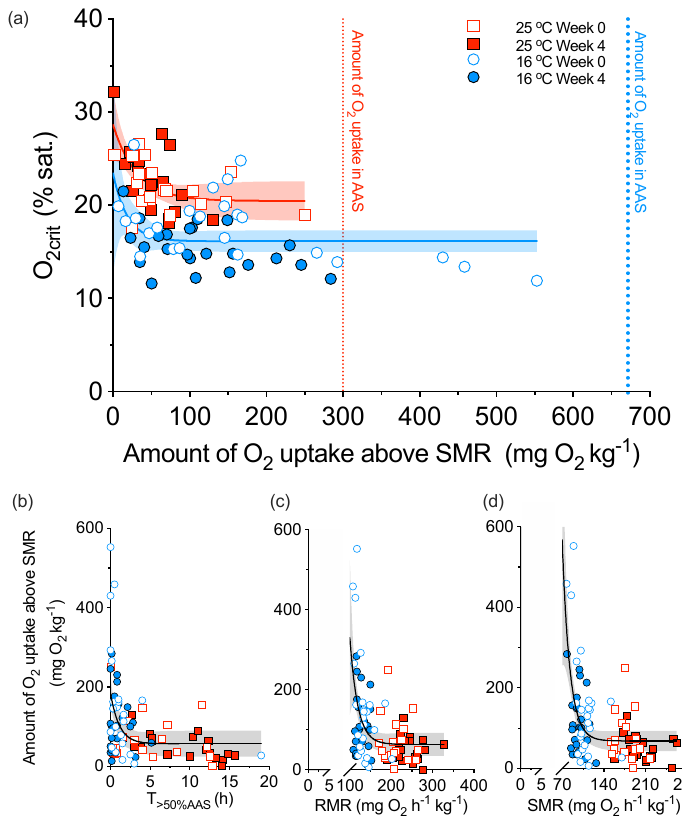
Figure 1. The interdependence of critical dissolved oxygen (O 2crit ), behavioural activity, and standard metabolic rate (SMR) in European sea bass ( Dicentrarchus labrax ). Fish were acclimated to either 16 or 25 ◦ C, and the same fish from each acclimation temperature were repeatedly measured after 4 weeks to assure the reproducibility of the first measurement. The activity level in hypoxia was measured by the amount of oxygen (O 2 ) uptake above SMR during a hypoxia challenge test. Behavioural activity in normoxia was measured by the routine metabolic rate (RMR) and time spent above 50% absolute aerobic scope (T > 0.5%AAS). The amount of O 2 uptake in absolute aerobic scope (AAS) is what fish would consume if using a full AAS in the hypoxia challenge test. The non-linear regression analyses used a one-phase association model. Panel ( a ) explores how activity in hypoxia can affect O 2crit . Panels ( b – d ) explore if the sea bass showed a consistent behavioural activity pattern in normoxia and hypoxia. The figure and data are adapted from